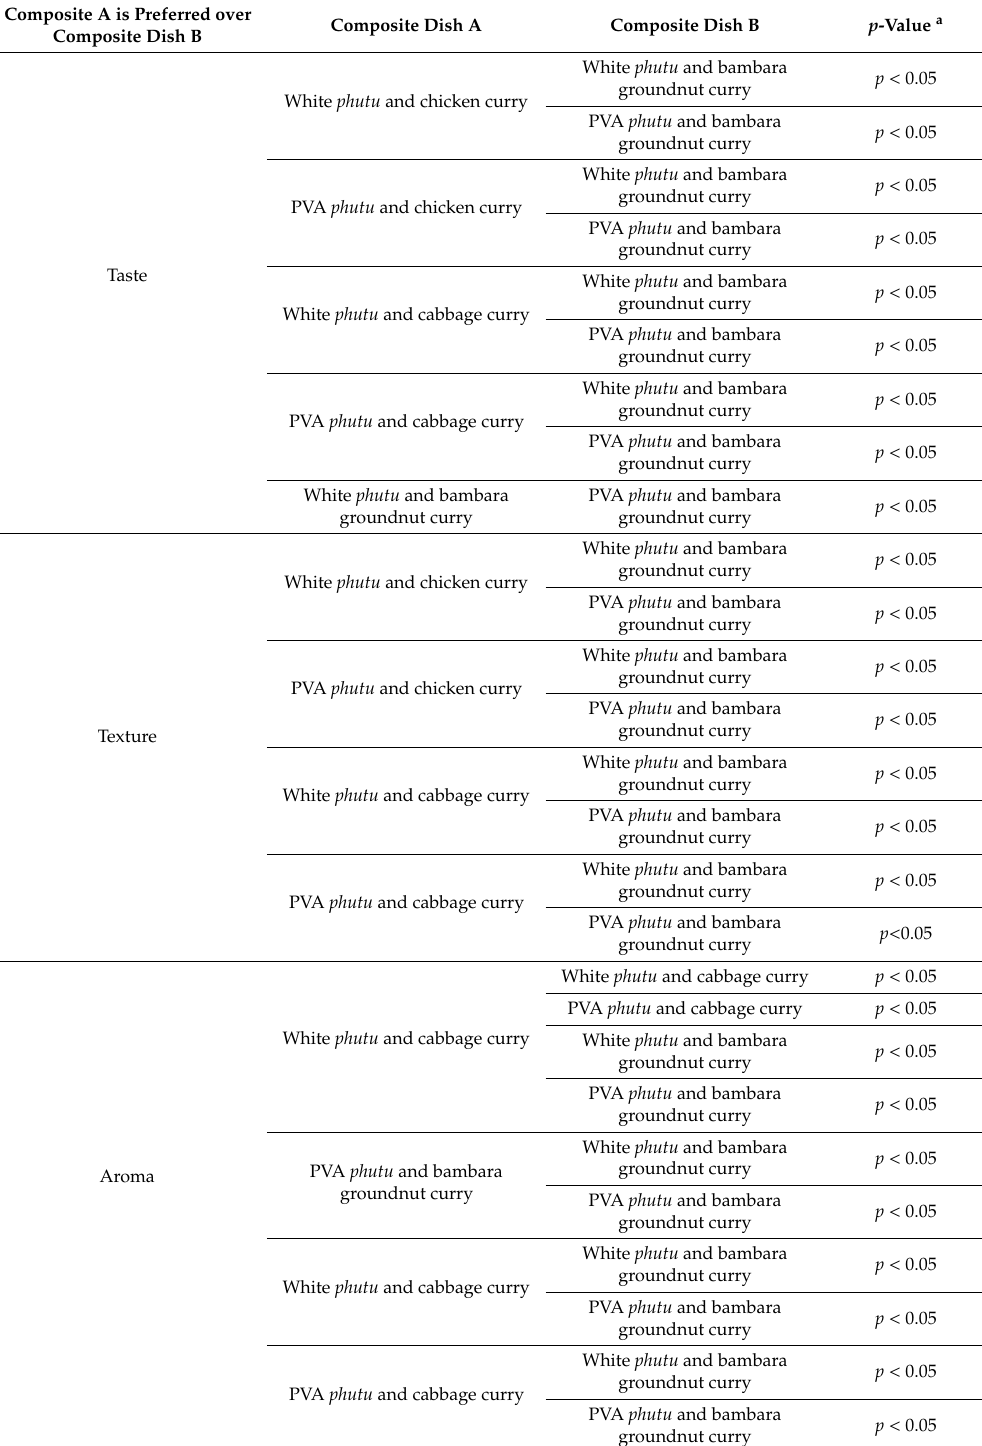
Table 7. Significant di ff erences between composite dishes and the sensory attributes of taste, texture and